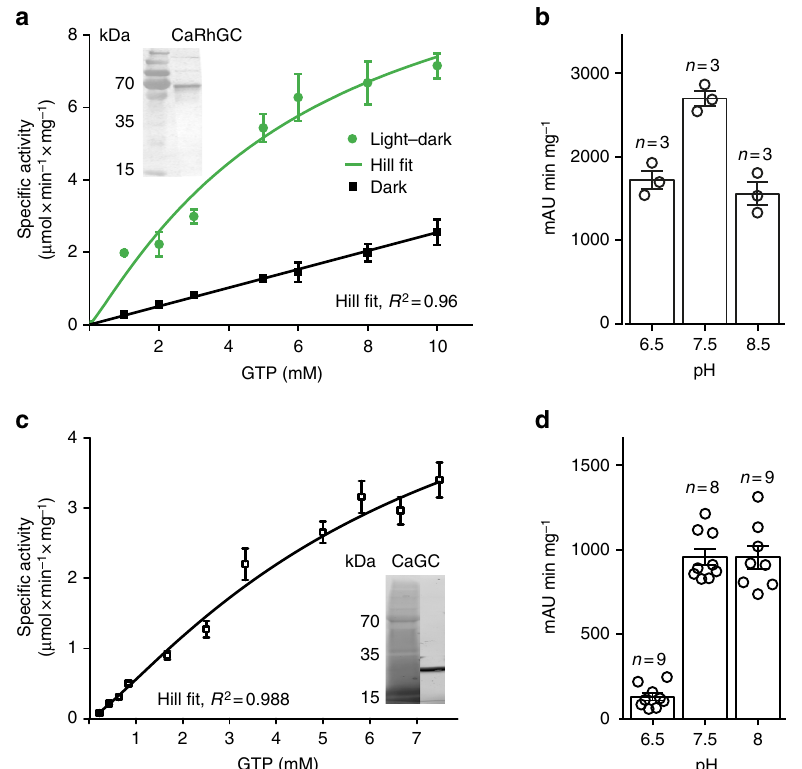
Fig. 4 Enzymatic characterization of CaRhGC and truncated CaGC. a Speci fi c activity of detergent-puri fi ed CaRhGC in light (522 nm, 0.01 mWmm − 2 , green trace, dark activity subtracted) and darkness (black trace), determined at increasing GTP concentrations (0.5 – 10 mM GTP/Mn 2 + , pH = 7.5, n = 3). cGMP was quanti fi ed using RP-HPLC, a Hill fi t was applied to the illuminated data (dark activity subtracted). Inset shows immunoblot (anti-his) of puri fi ed CaRhGC (MW = 71 kDa). b pH dependence of CaRhGC. cGMP peak areas (mAU*min) per mg protein were quanti fi ed after illumination of CaRhGC for 5 min (522 nm, 1 µ W mm − 2 , 1 mM GTP/Mn 2 + ) at the indicated pHs. c Speci fi c activity of puri fi ed truncated guanylyl cyclase (CaGC) in the presence of increasing substrate concentrations (0.2 – 7 mM GTP/Mn 2 + , pH = 7.5, n = 3, data were fi tted according to Hill). The inset shows the SDS gel of puri fi ed CaGC (MW = 21.5 kDa). d pH dependence of CaGC. cGMP peak areas (mAU*min) per mg protein were quanti fi ed after 5 min incubation of CaGC with 1 mM GTP/Mn 2 + at the indicated pHs. Bar graphs show means ± s.e.m.